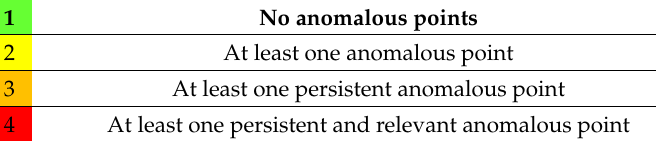
Table 2. Classes of the municipality classifications based on the presence, persistency and relevance of AP. 1 No anomalous points 2 At least one anomalous point 3 At least one persistent anomalous point 4 At least one persistent and relevant anomalous